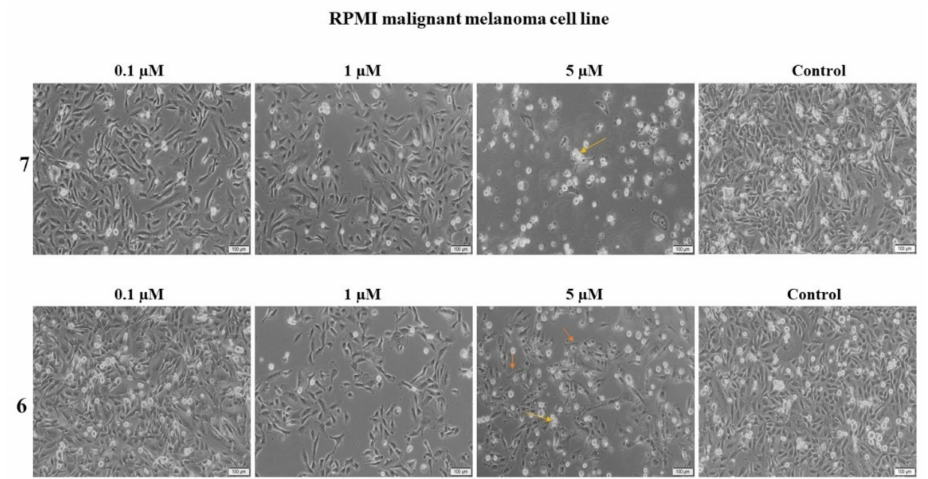
Figure 10. Morphological aspect of the RPMI cells after the treatment with compounds 6 and 7 (0.1, 1, and 5 µ M) for 24 h. The yellow arrows indicate the round and detached cells, and the orange arrows indicate the vacuoles noticed following the treatment with compounds 6 and 7 . The scale bars represent 100 µ m.